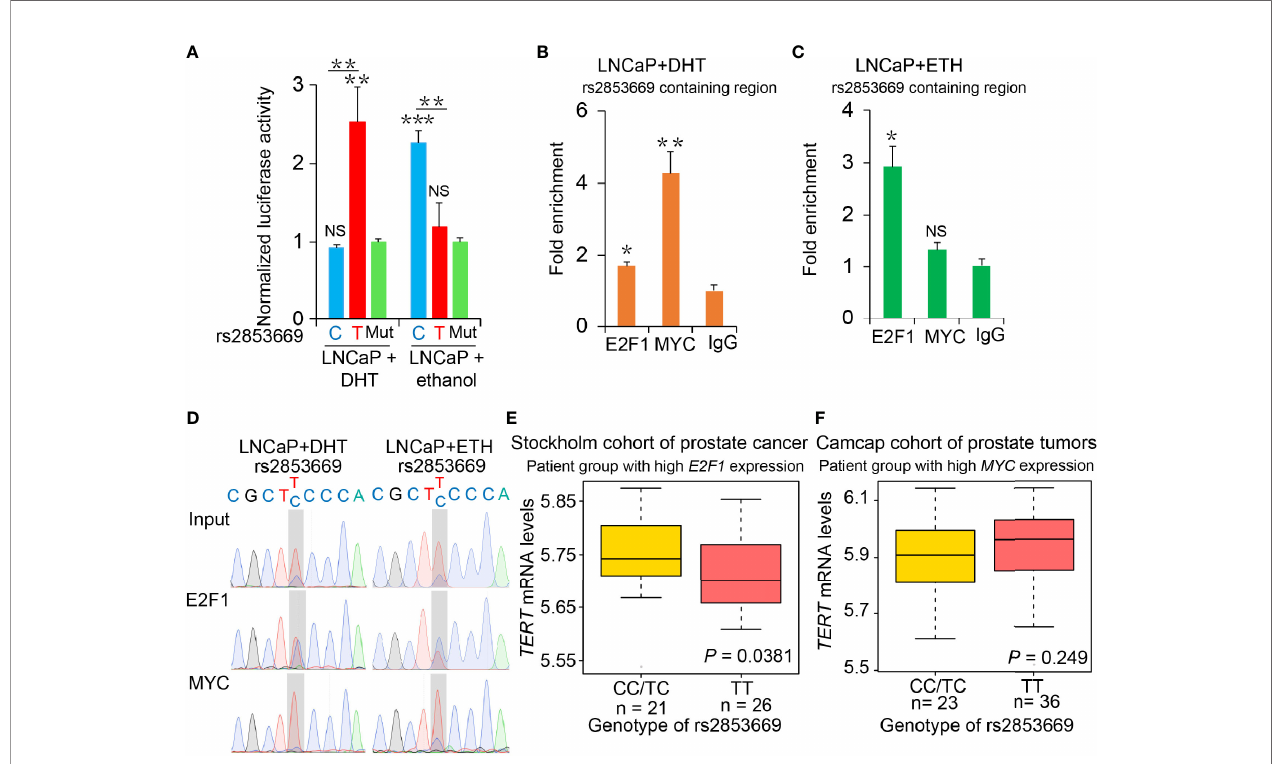
FIGURE 3 | The binding preference of E2F1 and MYC at rs2853669 affected TERT expression. (A) Luciferase reporter assays showing increased promoter activity of the T allele at rs2853669 relative to the C allele in LNCaP cells after androgen treatment. The promoter activity of the T allele at rs2853669 relative to the C allele was diminished in LNCaP cells after removing androgen. Mut, deletion of MYC or E2F1-binding site with rs2853669. (B, C) ChIP-qPCR results showed MYC and E2F1 chromatin binding at rs2853669-containing region in LNCaP cells under androgen stimulation (B) or withdrawal (C) . (D) MYC or E2F1 favored binding to the T or C allele at rs2853669 with or without androgen treatment determined by ChIP followed by Sanger sequencing. (E, F) The association between rs2853669 genotype and TERT expression in prostate tumor samples. C allele of rs2853669 was signi fi cantly associated with elevated mRNA expression of TERT in E2F1 high expression group (E) ; Homozygous TT genotype of rs2853669 was correlated with higher expression of TERT in MYC high expression group (F) . Patients were pre- strati fi ed based on median expression of E2F1 or MYC . p- values were examined by a log-rank test. Error bars, s.e.m. n = 3 technical replicates. * p < 0.05, ** p < 0.01, *** p < 0.001, Student ’ s t tests. NS, Non signi fi